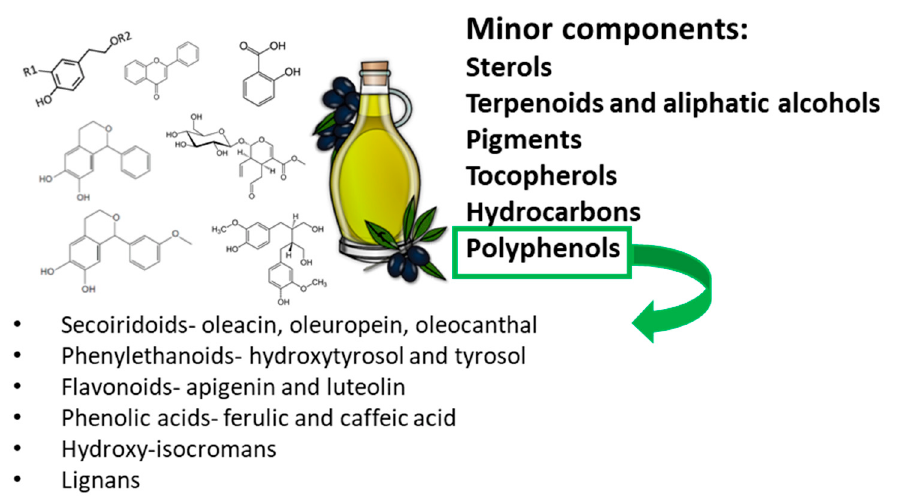
Figure 2. EVOO minor components—list of polyphenols.